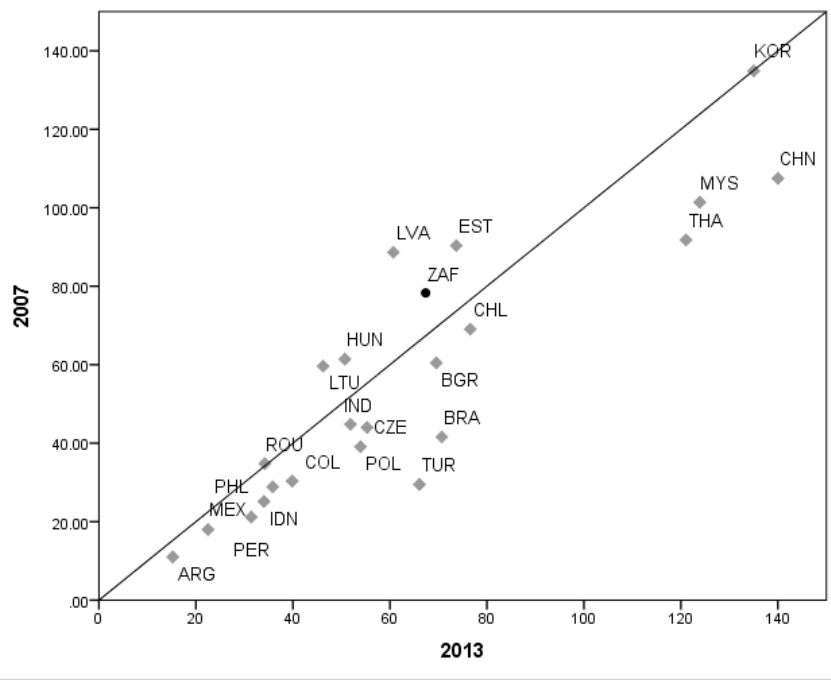
FIGURE 7: Domestic credit to private sector by banks (% of GDP)